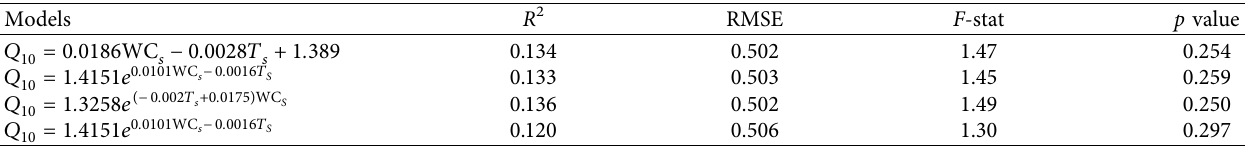
Table 1: Four coupling functions of ( T a , WC s ) were employed in the analyses of Q 10 with T a and WC s , with the fitted parameters and the statistics in model performance.